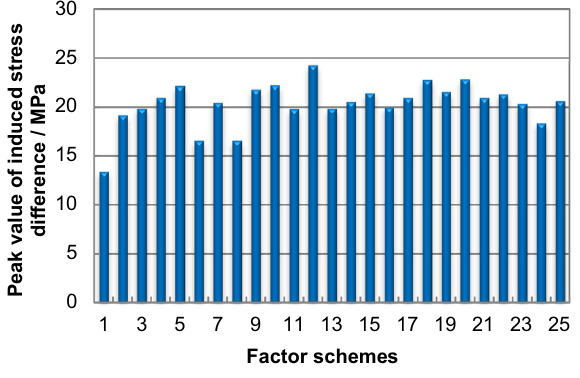
Fig. 8 The results of the peak value of induced stress difference under different factor schemes